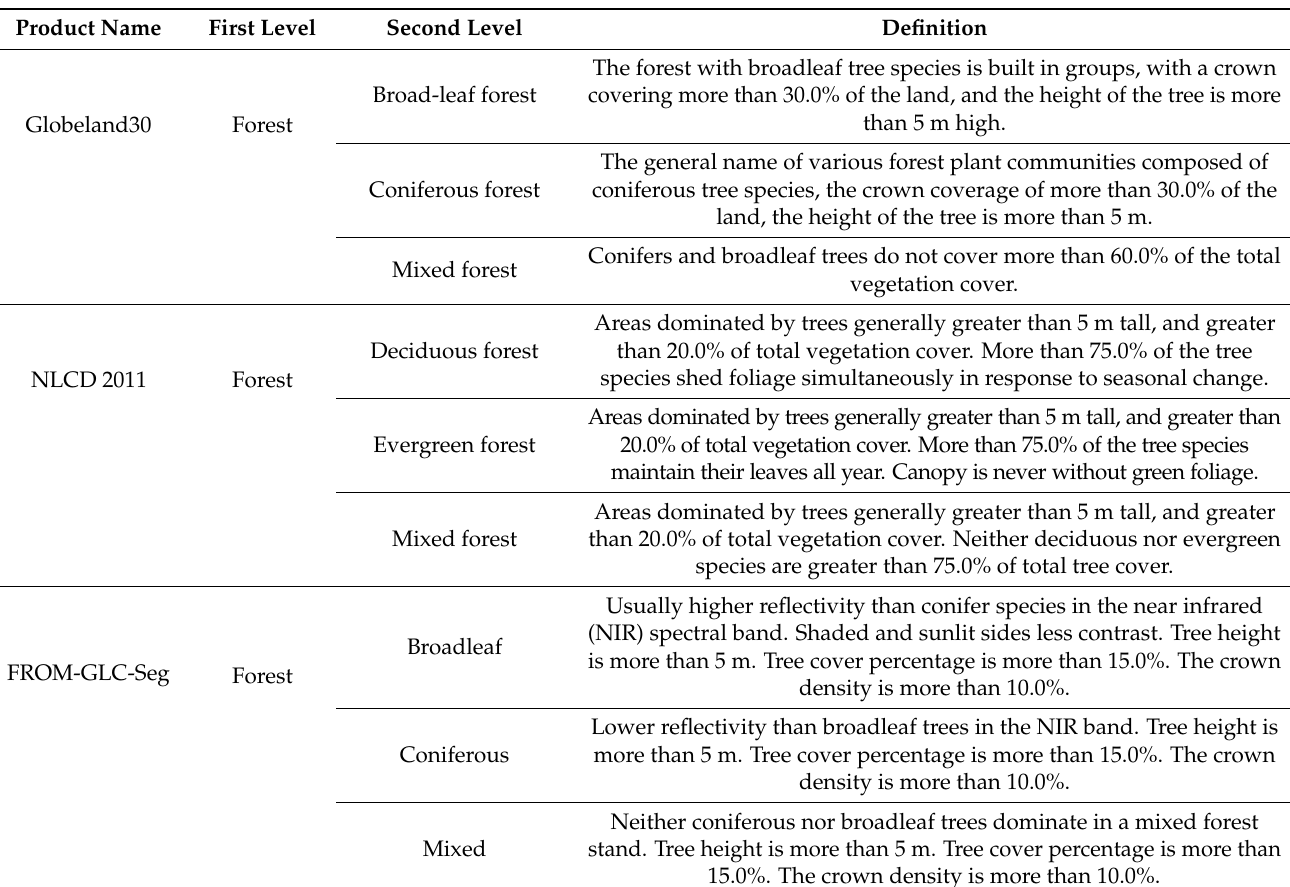
Figure 7. Forest map in land-cover products: ( a ) GlobeLand30; ( b ) NLCD 2011; ( c ) FROM-GLC-Seg. Table 2. Forest second level categories and definition of